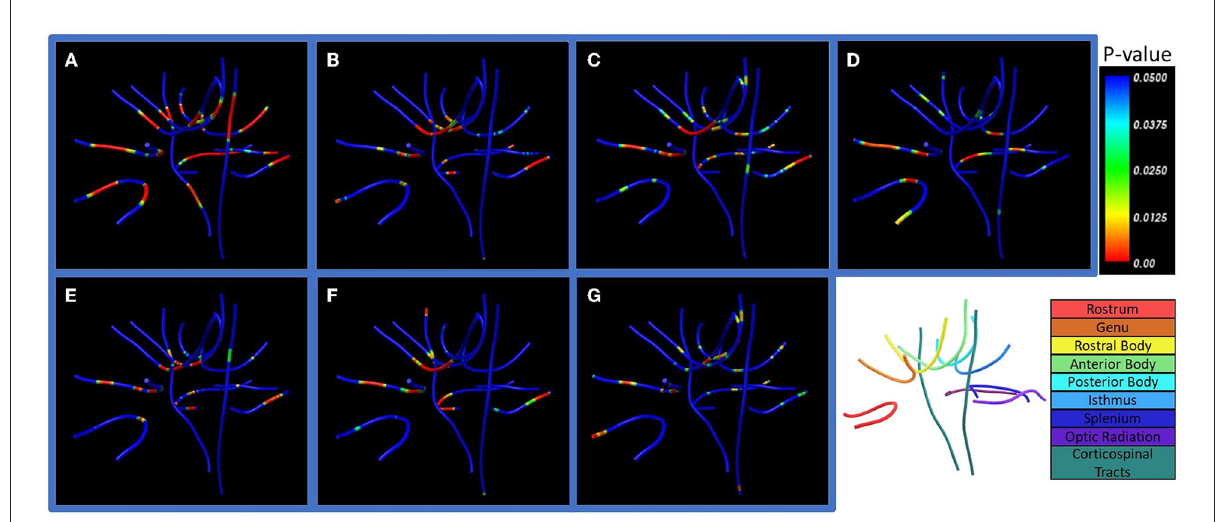
FIGURE6 Along-tract statistics between cohorts. Shown are (A) lesion extent, (B) orientation dispersion index (ODI), (C) fractional anisotropy (FA), (D) apparent fiber density (AFD), (E) axonal diameter, (F) intracellular volume fraction (ICVF), and (G) orientation distribution function (ODF) energy. The p -value indicates significance of pointwise cohort differences prior to multiple comparison corrections. Bottom right: Labels of the seven corpus callosum segments, optic radiation, and corticospinal white matter tracts examined in the study.